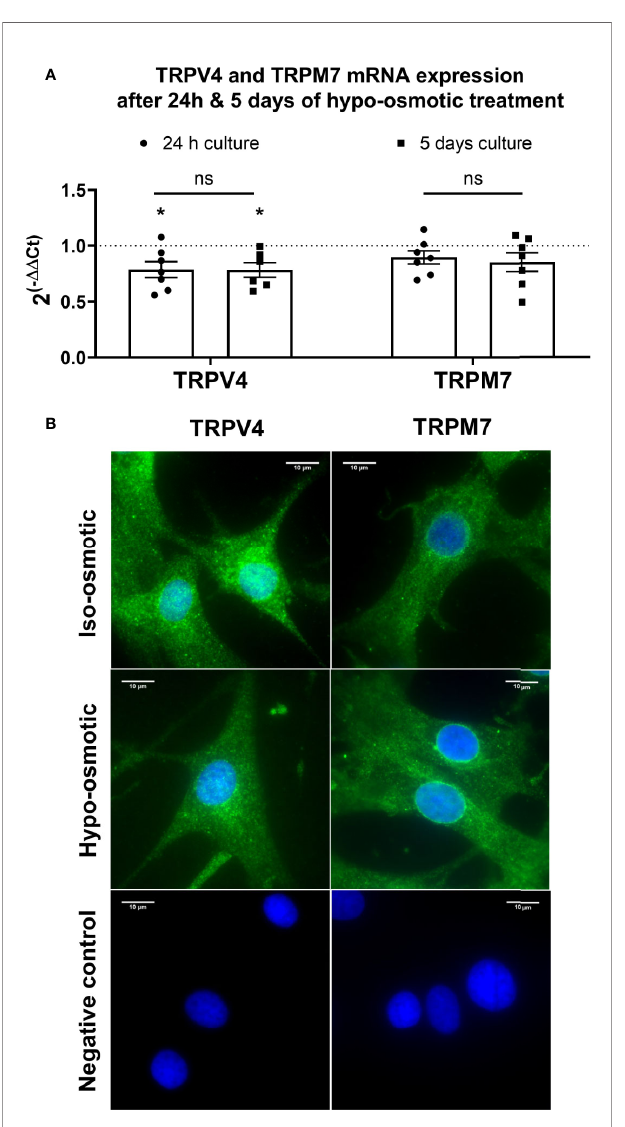
FIGURE 2 | The mRNA expression of (A) TRPV4 ( left ) and TRPM7 ( right ) channels in bovine nucleus pulposus (NP) cells. Graphs show 2 − DD Ct values normalized to the iso-osmotic control (mean ± SEM, n = 6-7). Asterisks indicates statistical signi fi cance (*p < 0.05) between iso- and hypo-osmotic conditions, bars compare the difference between 24 h and 5-day long treatments ( ns , no statistical difference de fi ned as p > 0.05). (B) Protein expression of TRPV4 (left top and middle) and TRPM7 (right top and bottom) after 24 h of culture in either iso- (top) or hypo-osmotic media (middle). For the negative control (bottom left and right) cells were incubated without primary antibody. TRPV4/M7 are stained green, nuclei were counterstained with DAPI (blue). Scale bar is 10 µm, n = 3.